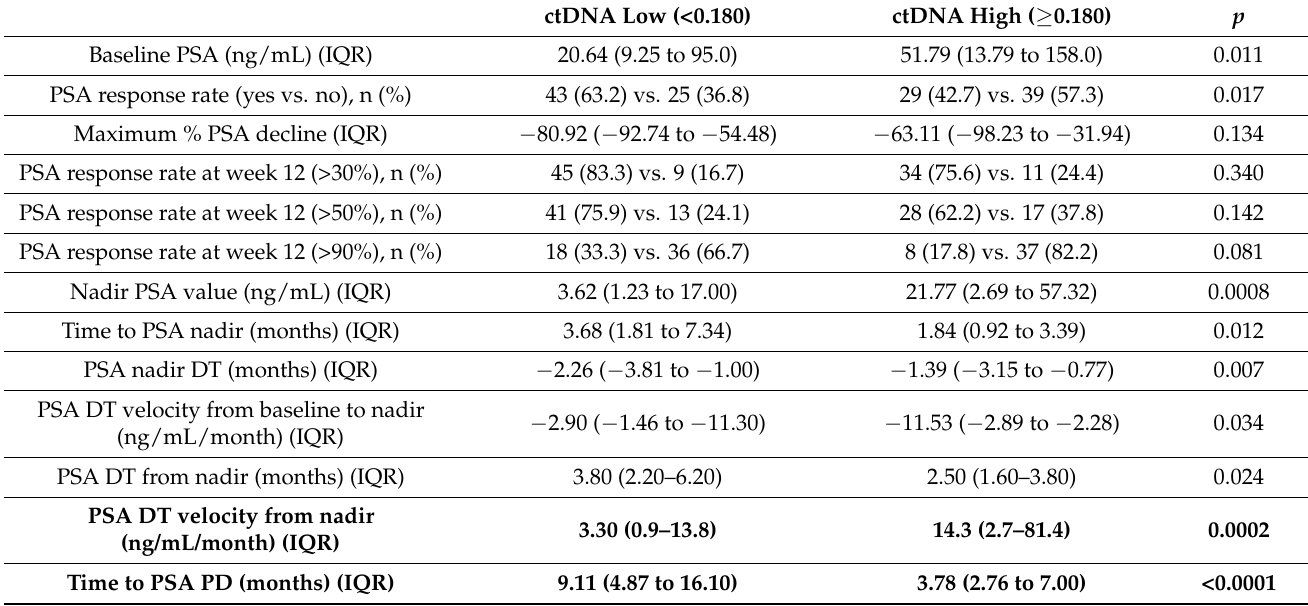
Table 2. Correlation of baseline ctDNA fraction and PSA kinetics. ctDNA Low (<0.180) ctDNA High ( ≥